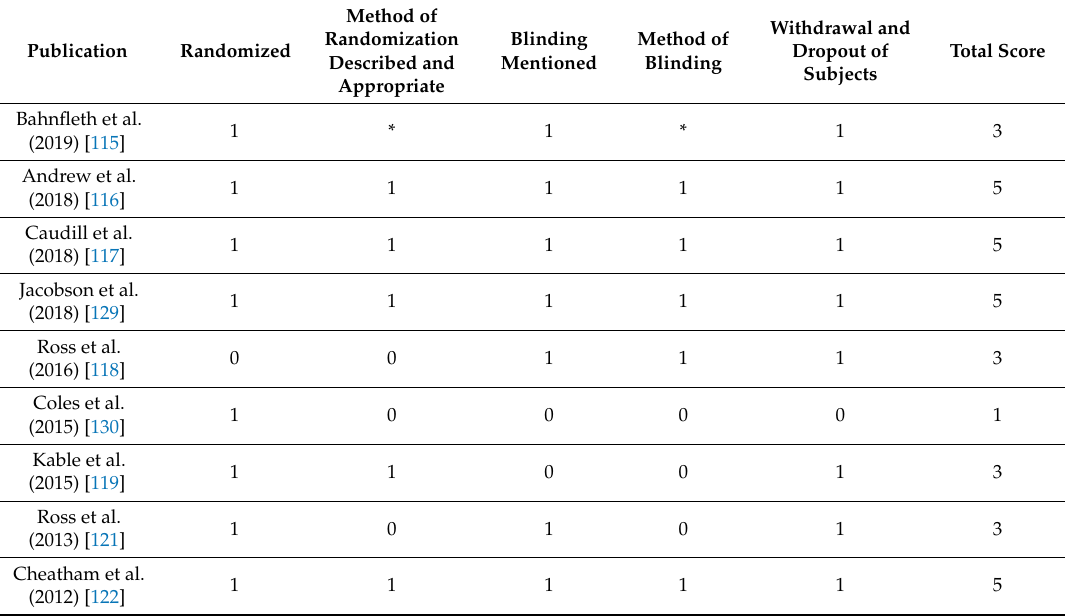
Table 3. Jadad criteria used to assess the quality of